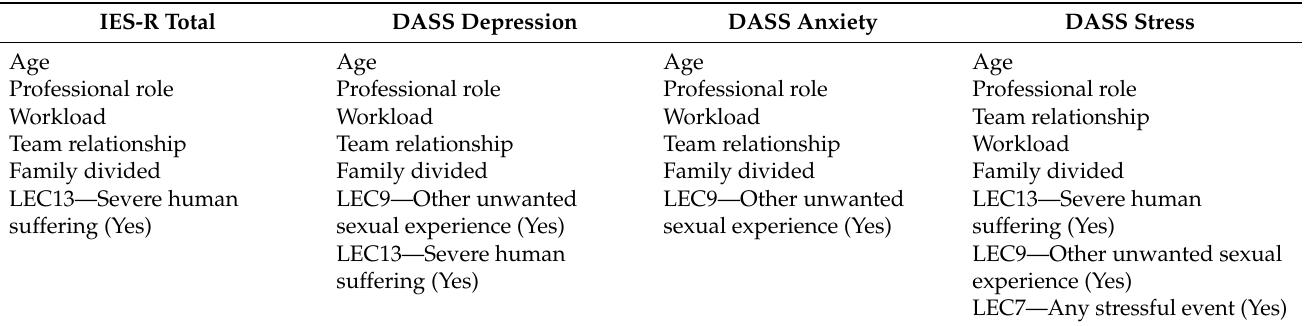
Table 5. Variables with a Relative Variable Importance (relVIM) of >20 resulting from the RF for each assessed